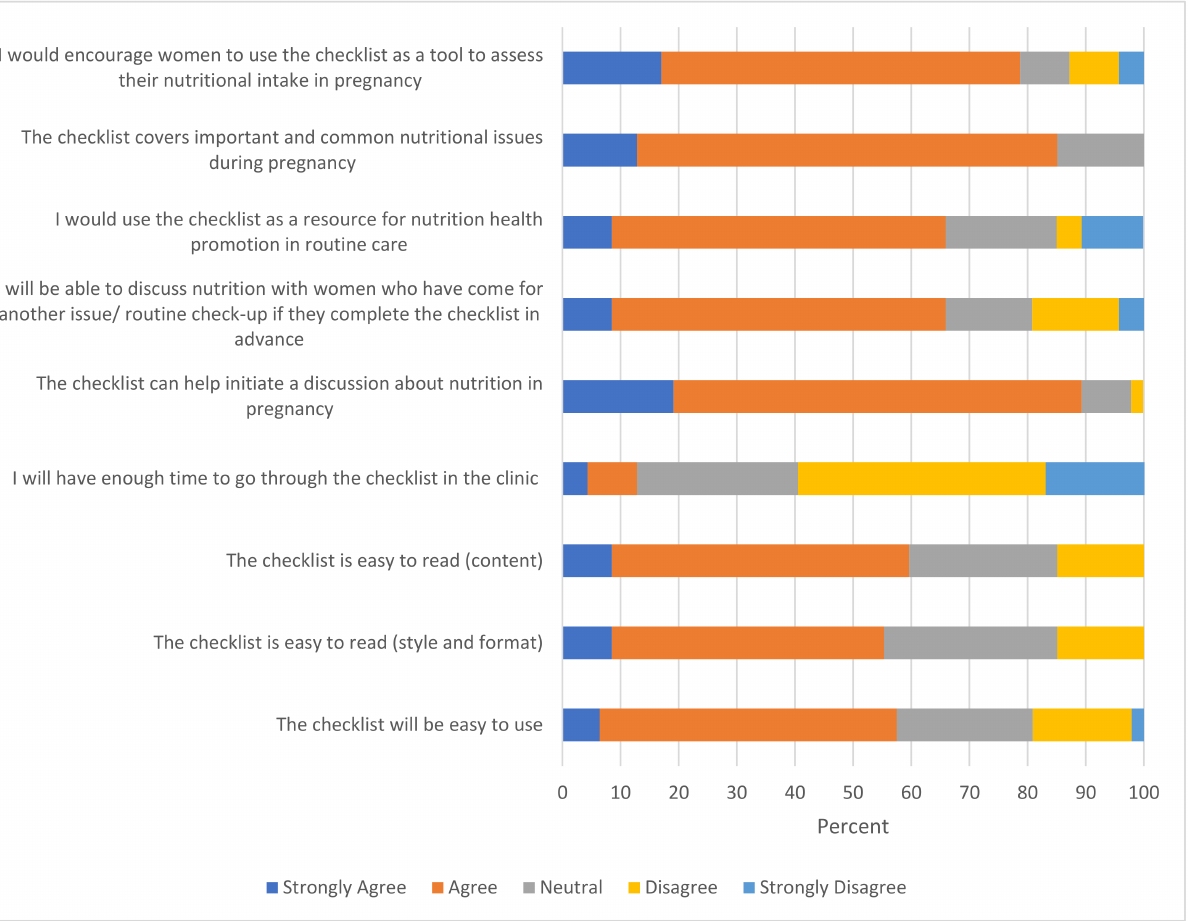
Figure 3. Findings for the questions on acceptability of the checklist (HCPs